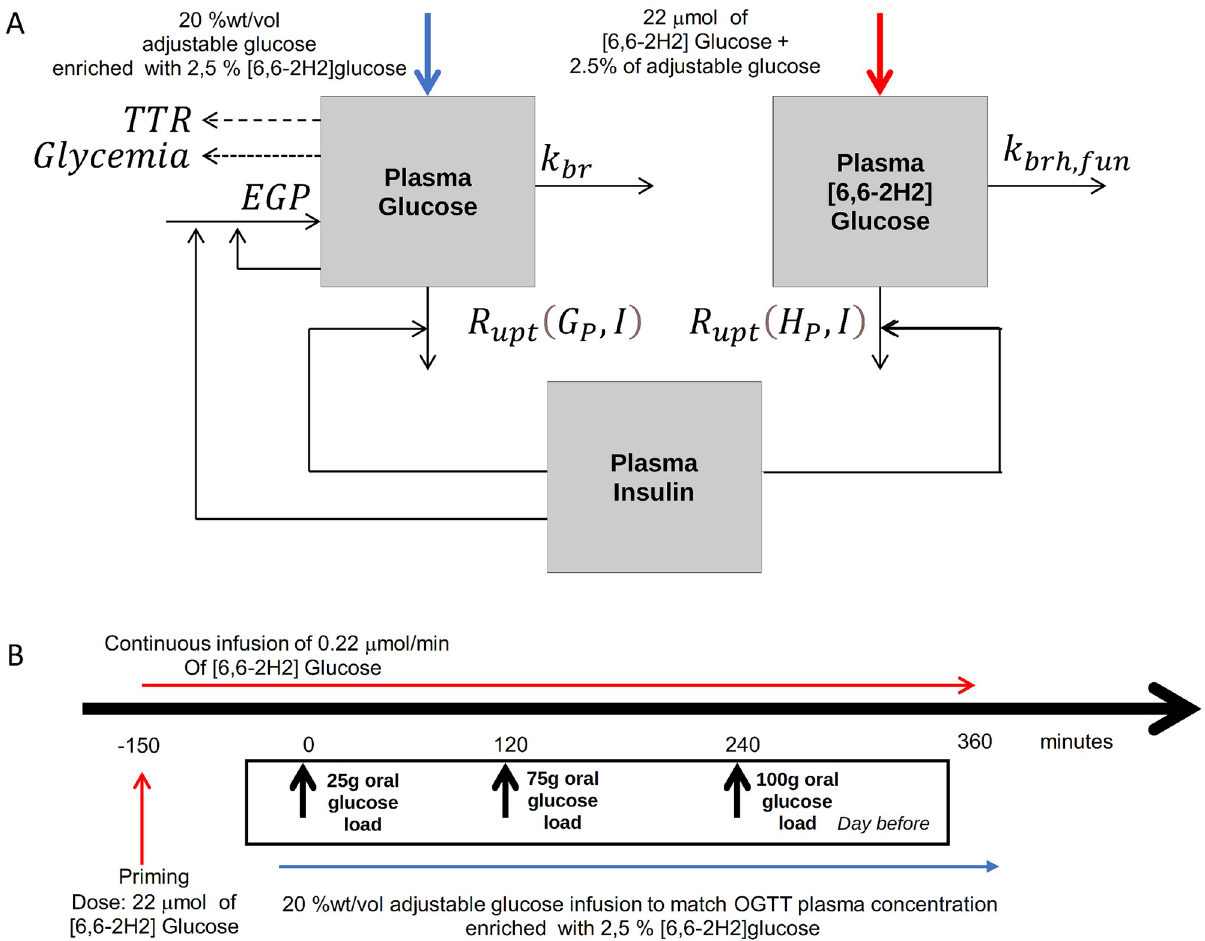
Fig 1. Block diagram. Schematic representation of both the one-compartment glucose model (panel A) and the whole experimental procedure (panel B). The schematic representation of the model summarizes the intravenous procedure performed on day 2.